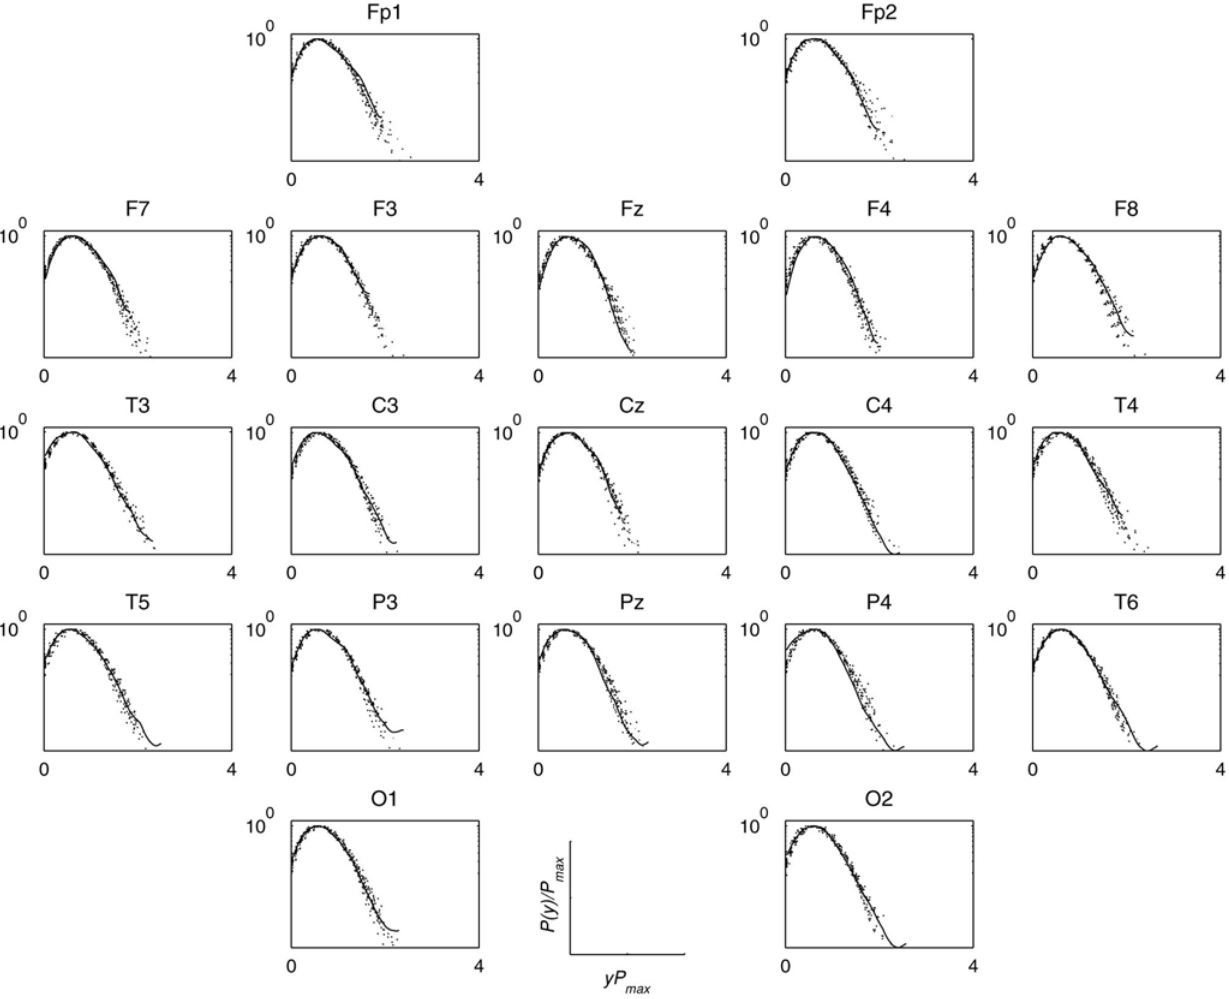
Figure 8. Surrogate analysis during mental imagery. Same as in Fig. 7 but during mental imagery. Note that the pdfs for frontal electrode regions being indistinguishable from those of surrogates and of other electrode regions, which is in sharp contrast with visual perception (Fig.